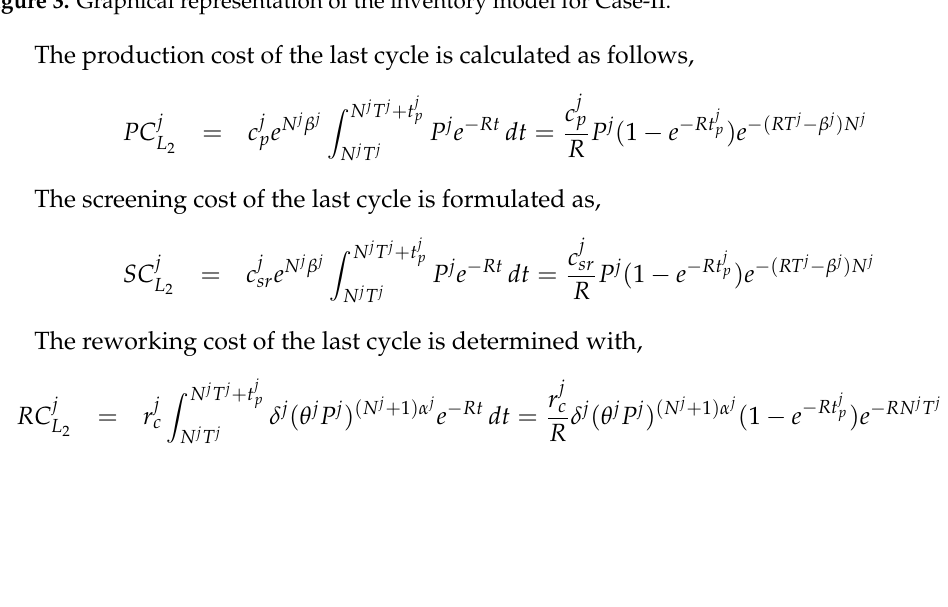
Figure 3. Graphical representation of the inventory model for